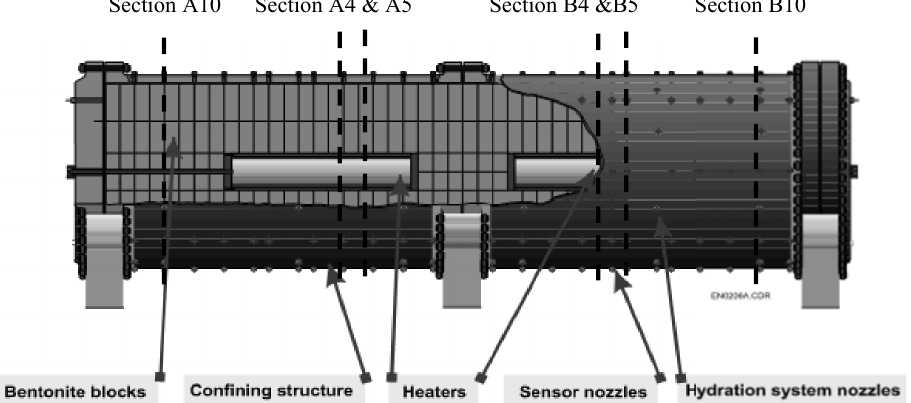
Fig. 2 – Layout of the large scale heating